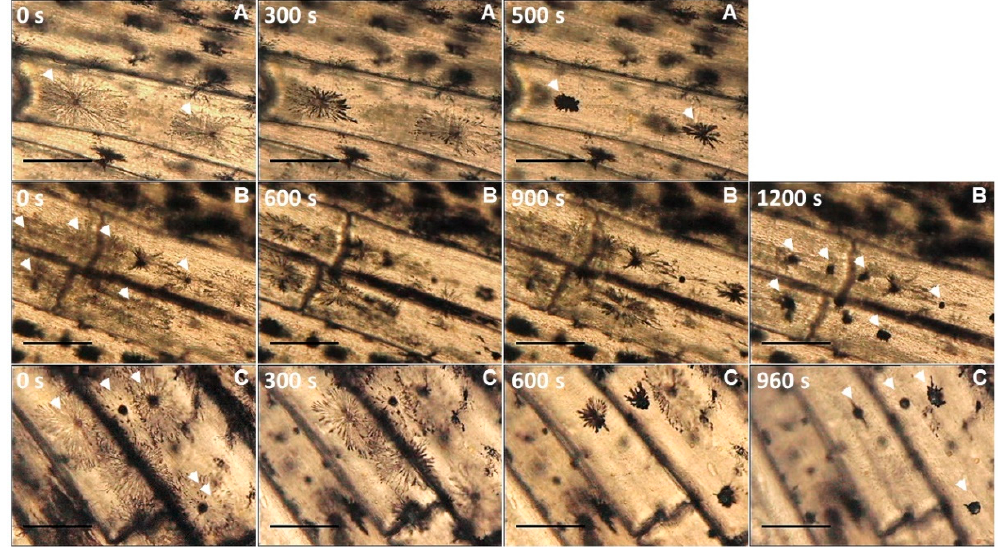
Figure 3. Representative light microscopy images of gilthead seabream fin samples exposed with either synthetic melatonin ( Pael A ), Bioriex-sample-1 ( Pael B ) and Bioriex-sample-2 ( Pael C ) at di ff erent times. Bar = 100 µm. Arrowheads indicate melanophores that greatly vary in their morphology from 0 s to the final exposure time.